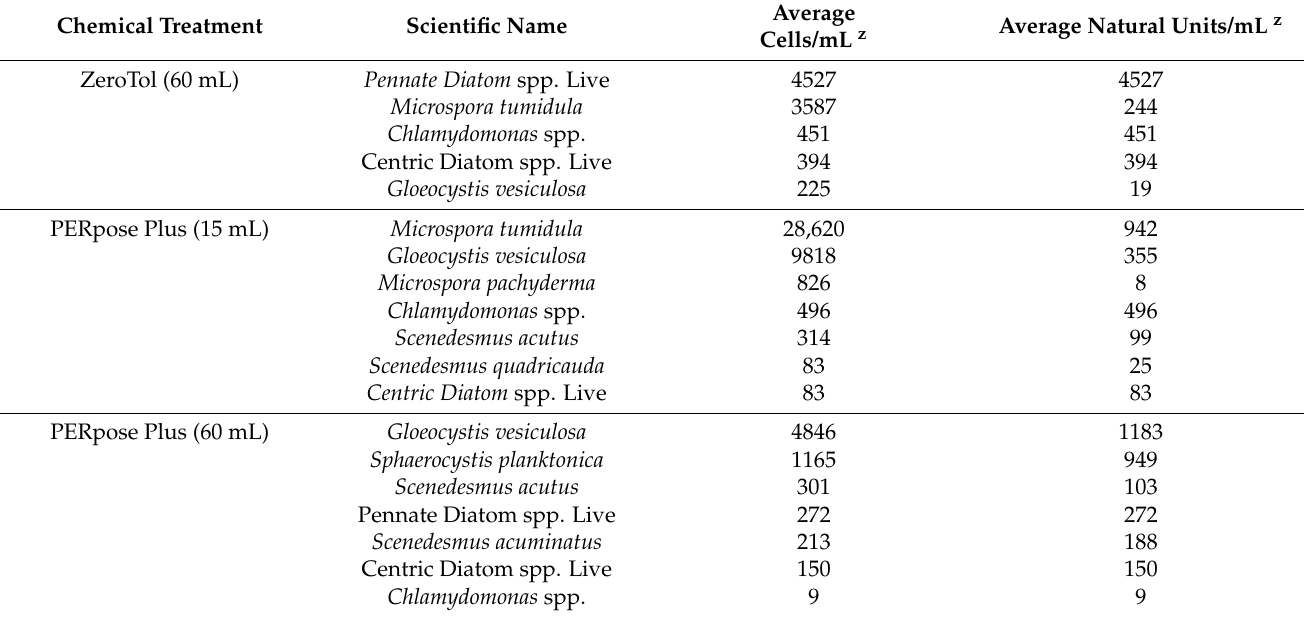
Figure 3. Effects of rate of three hydrogen peroxide products, ZeroTol (Z), PERpose Plus (PP), 3% hydrogen peroxide (15, 30, 45, and 60 weekly; 15, 30, 45, and 60 mL weekly; 70 mL weekly), and control on dissolved oxygen (DO) levels of nutrient solution in ebb and flow hydroponic systems at OSU research greenhouses in Stillwater, OK. Treatments were applied weekly starting 3 days after transplanting3 for ZeroTol and Purpose Plus and 7 days for hydrogen peroxide for experiment one. 4. Discussion